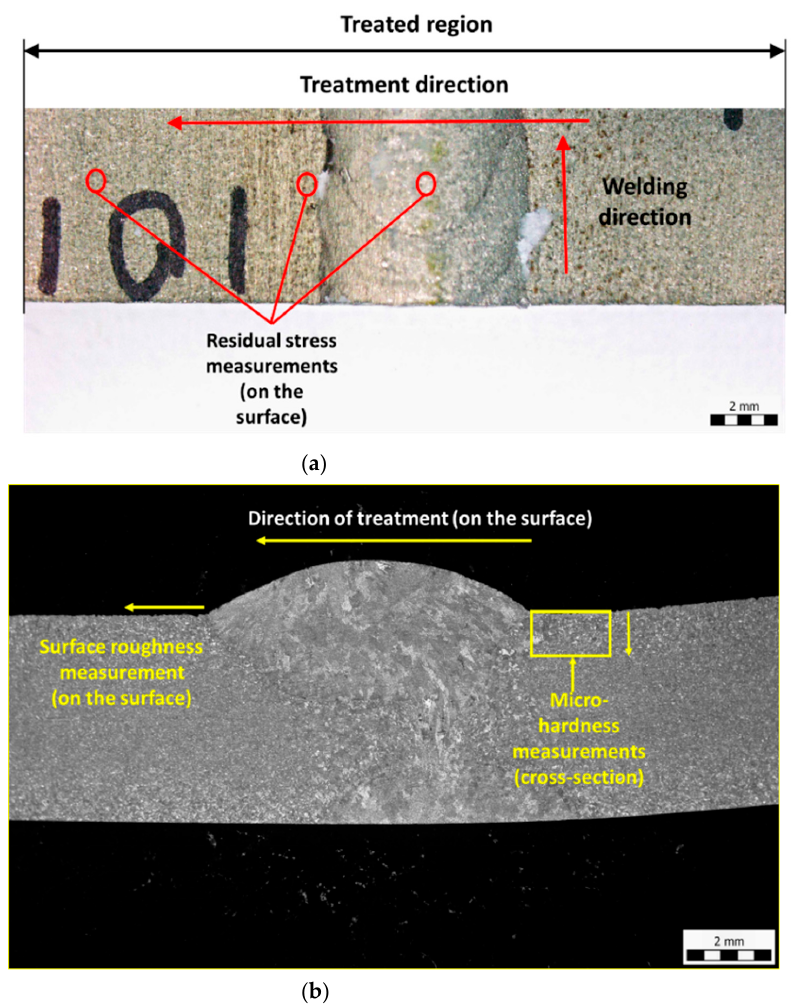
Figure 2. Optical Microscopy (Macro structure) of ( a ) the surface of the sample and ( b ) a cross-section of the sample showing the direction and regions selected for the measurements.